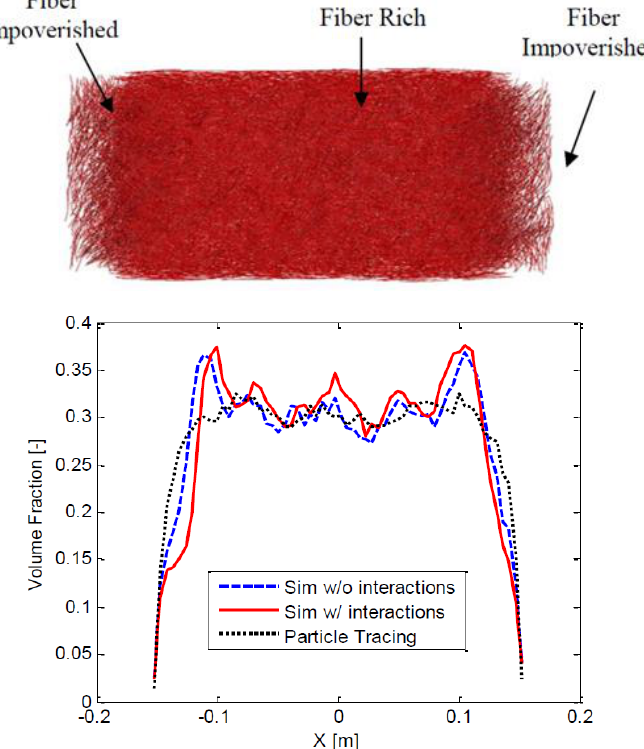
Figure 4. Mechanistic model predictions of fiber volume fraction over distance from the part center ‘X’ during biaxial flow in compression molding with long fiber reinforced plastics [9] .